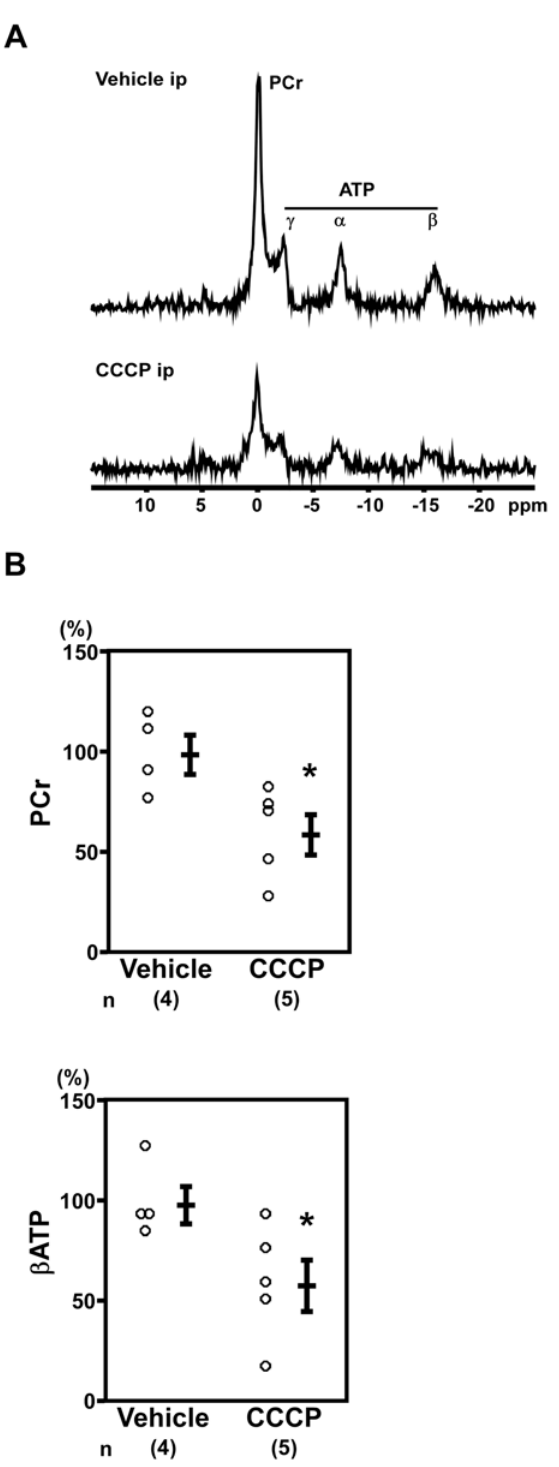
Figure 4. Phosphocreatine and ATP were decreased in the hearts CCCP-administered rats. (A) Representative images of in situ cardiac 31 P magnetic resonance spectra. ppm, parts per million. (B) The rats administered CCCP showed decreased PCr and β ATP (Vehicle: n = 4, CCCP: n = 5). * P < 0.05 versus vehicle-administered rats.